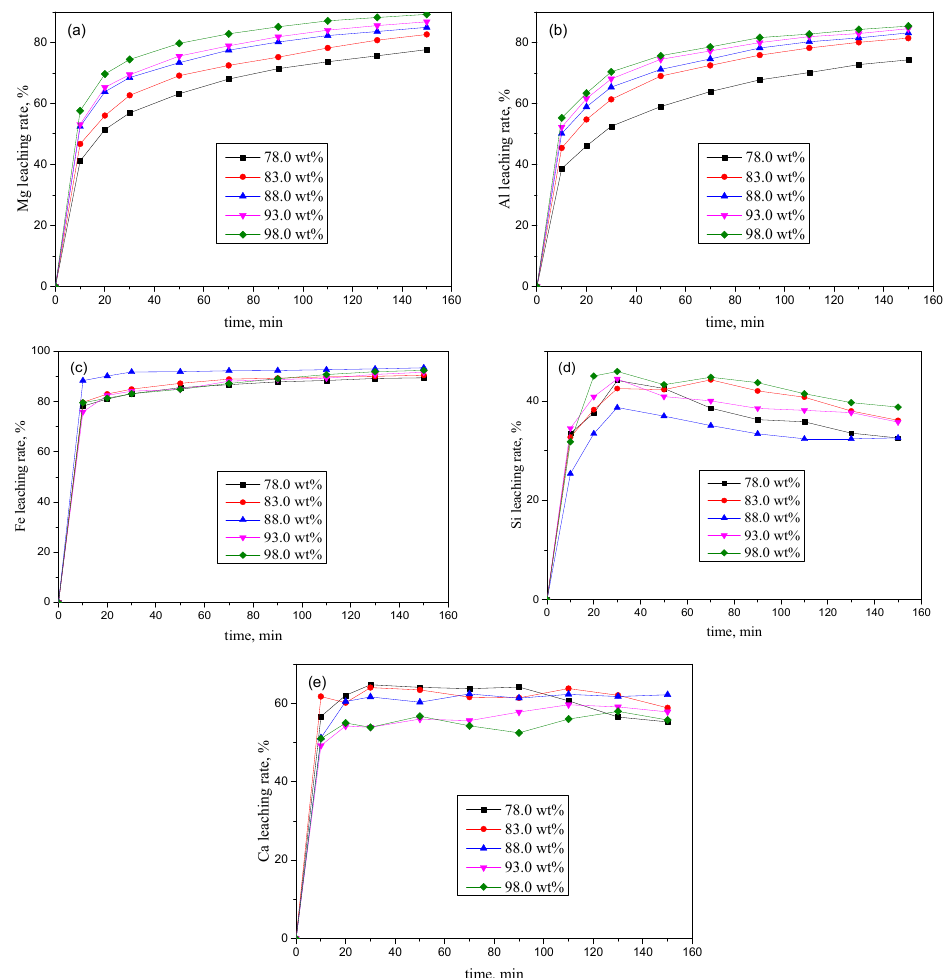
Figure 7. E ff ects of sulfuric acid concentration on the leaching of impurities: ( a ) Mg; ( b ) Al; ( c ) Fe; ( d ) Si; ( e ) Ca.